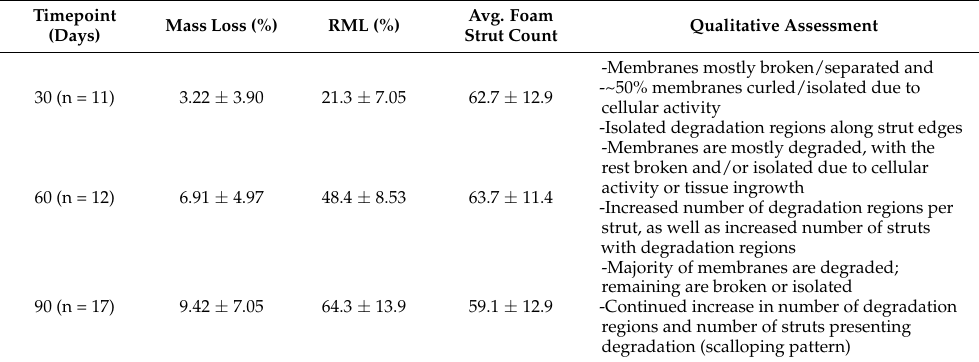
Table 5. PED degradation quantification/qualification in a porcine artery model 1